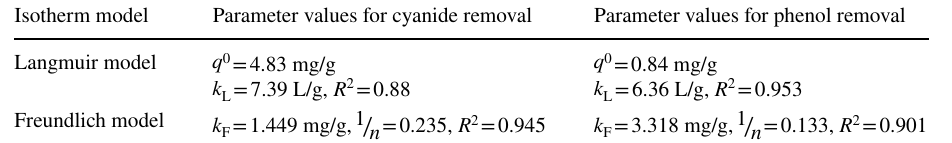
from fitting the adsorption equilibrium data